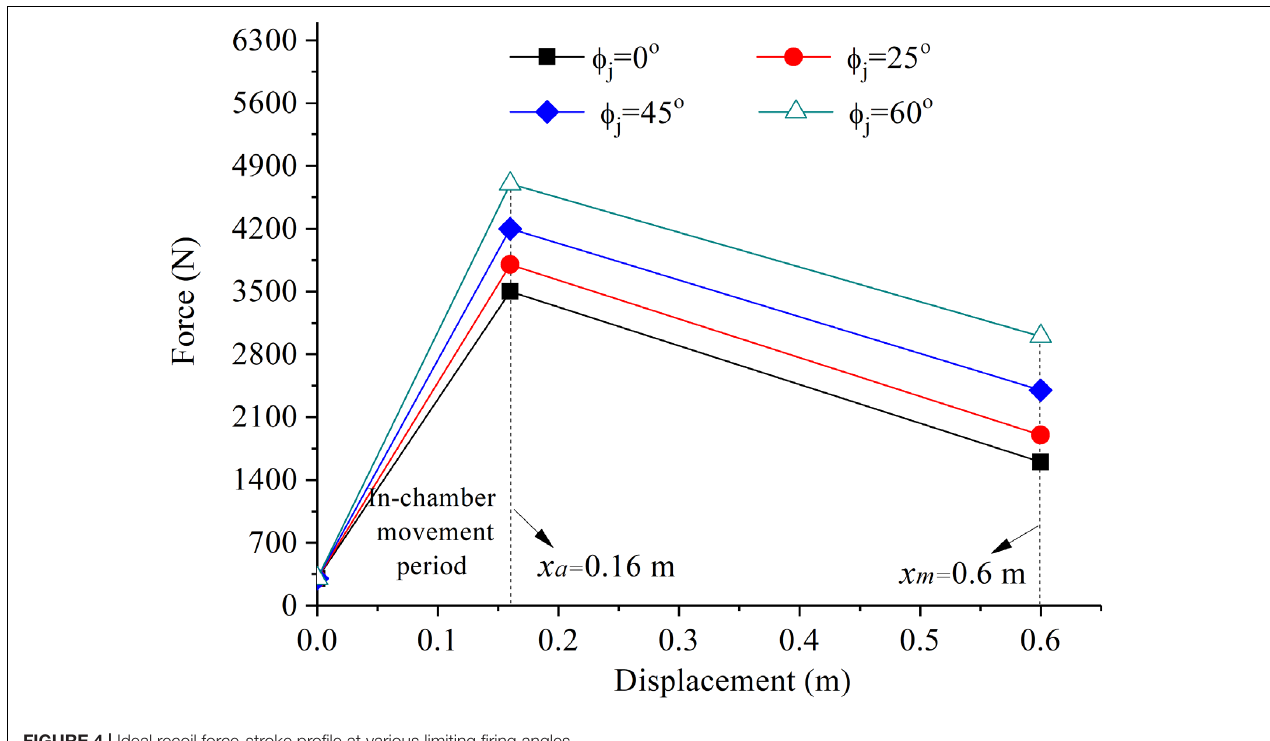
FIGURE 4 | Ideal recoil force-stroke profile at various limiting firing angles.